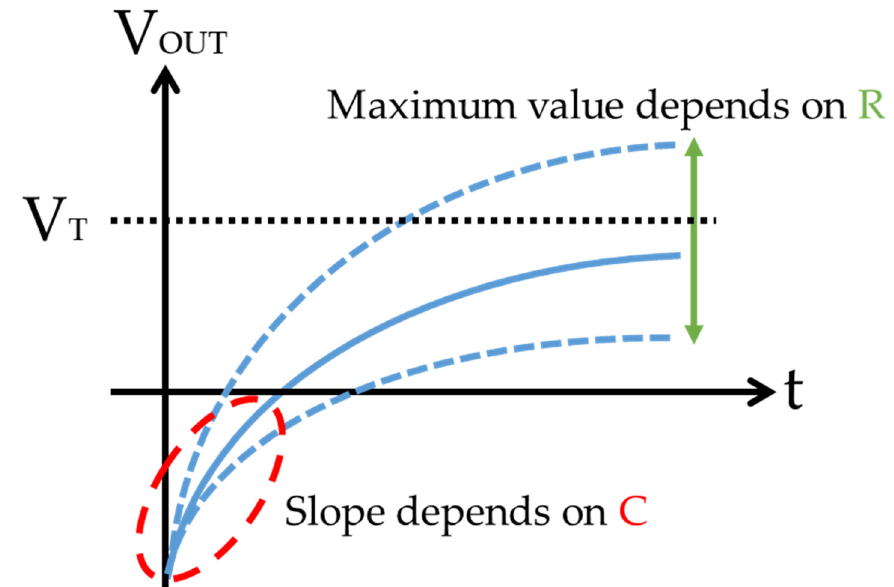
Figure 7. Voltage transient characteristics when the current is applied to the soil.